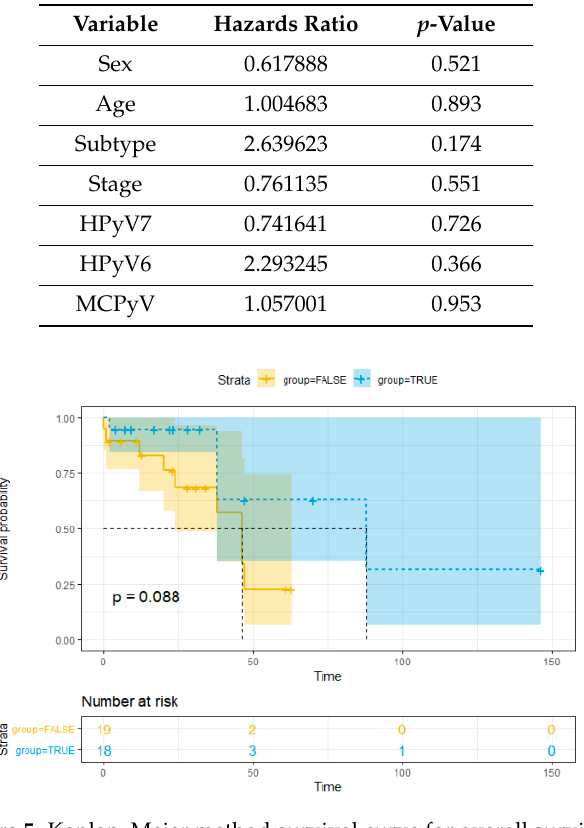
Figure 5. Kaplan–Meier method survival curve for overall survival.